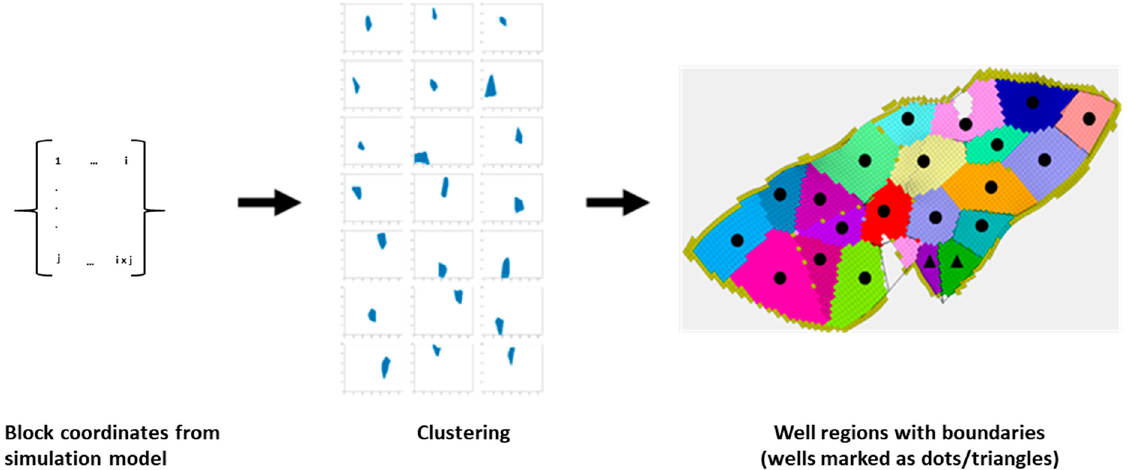
Figure 4. Well regions (various colors) result from the clusters for the field case study, with production wells (black dots) and existing injection wells (black triangles).